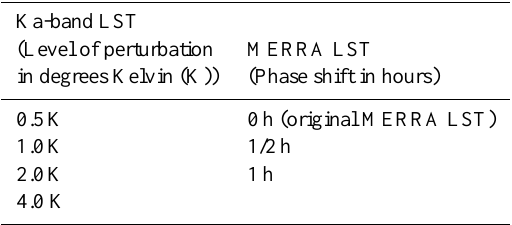
Table 3. Evaluated land surface temperature